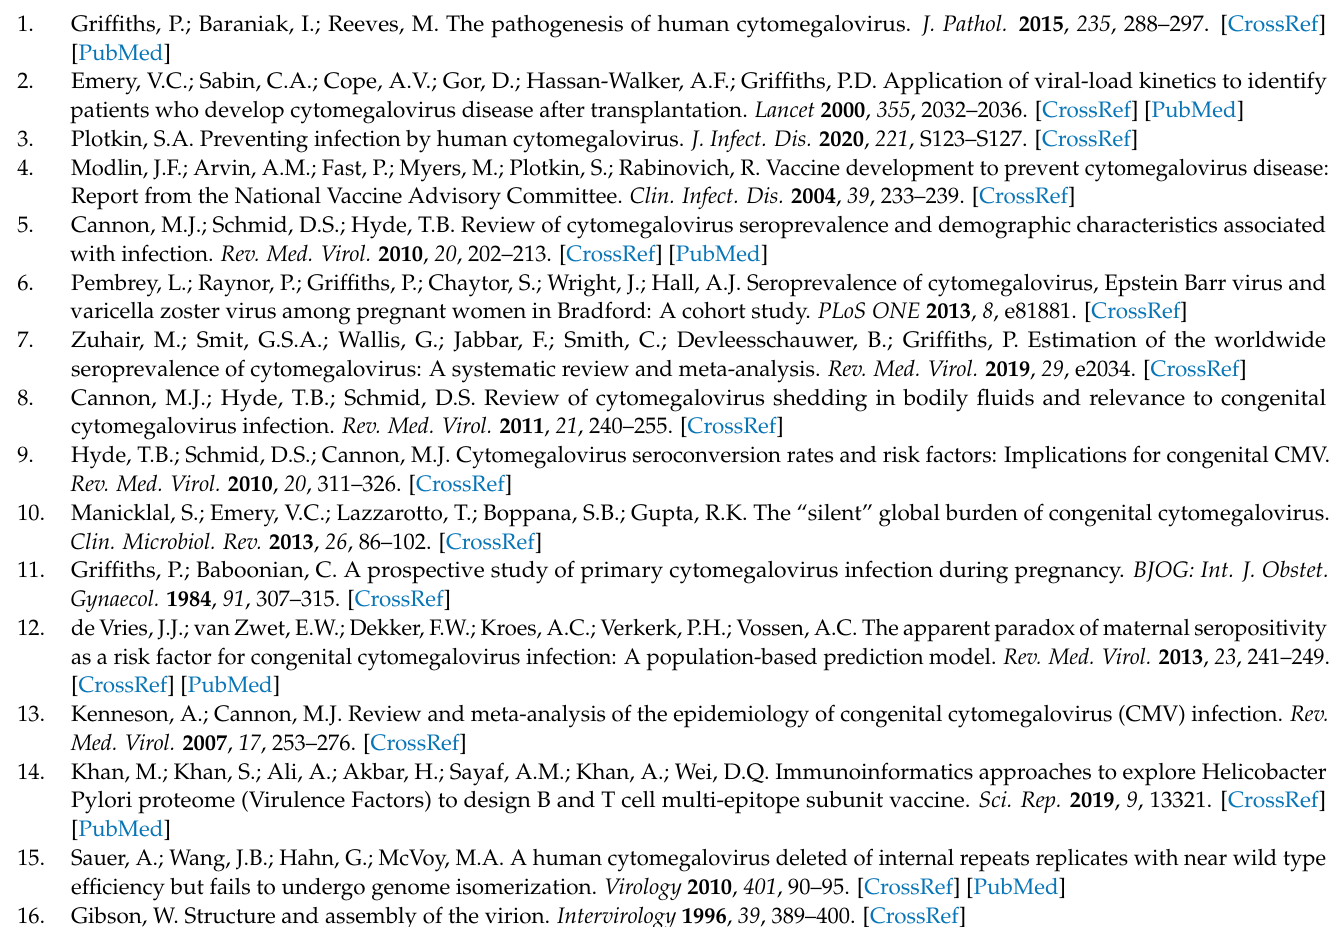
Figure S2: Showing structural validation of each MEVC designed against HCMV through Prosa-web analysis and Ramachandran plot. (A–D) represents the Prosa-Web analysis and Ramachandran plot of MEVCs designed against each target protein i.e., US3, UL15A, UL41A and UL40, respectively. Figure S3: Showing the interaction patterns of each MEVC designed against HCMV with human TLR4. (A–D) represents the formation of different interactions formed between each MEVC with human TLR4 characterized for each of the target protein i.e., US3, UL15A, UL41A and UL40, respectively. Table S1: Represents the identified transmembrane segments in the designed MEVCs against each target protein. Table S2: Represents the docking free energy calculations of the designed MEVCs with human